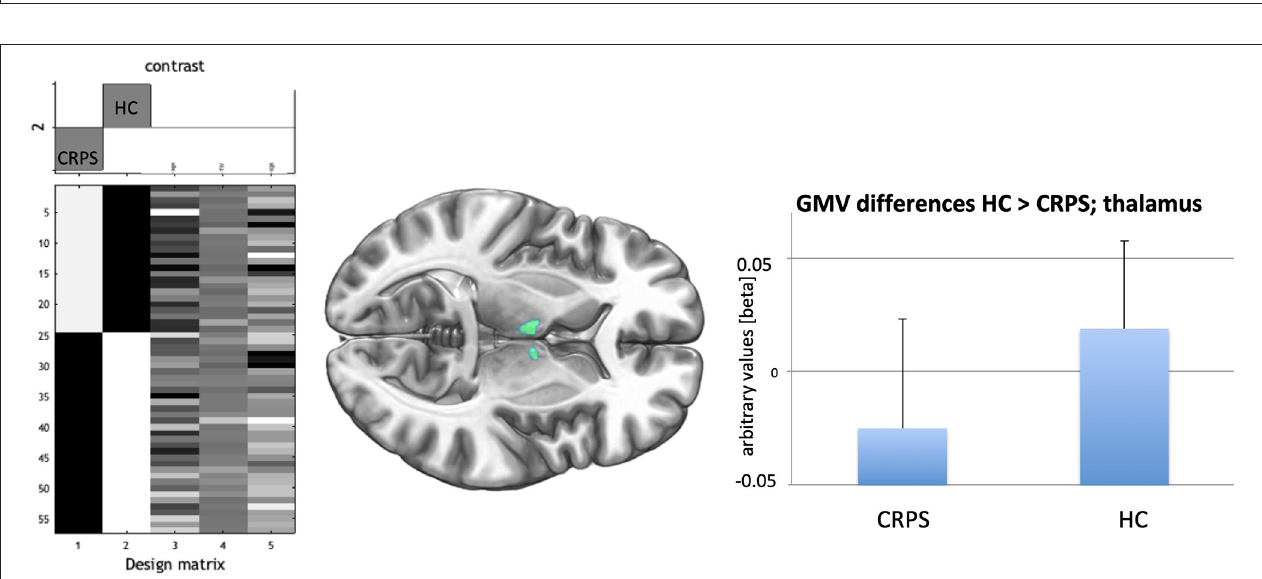
FIGURE 2 | (Left) Design matrix of the t-test comparison CRPS ( − 1) against HC ( + 1) with the three covariates age, total intracranial volume, and a quality score/IQR derived from CAT12 preprocessing. (Middle) Bilateral decreased GMV ( p FWE < 0.05; cluster level) in the medio-anterior thalamus for the CRPS patients indicated in green. (Right) bars indicate averages together with SDs (lines) for the GMV-effect in the highest significant voxel of the medio-anterior thalamus for CRPS patients and HCs.